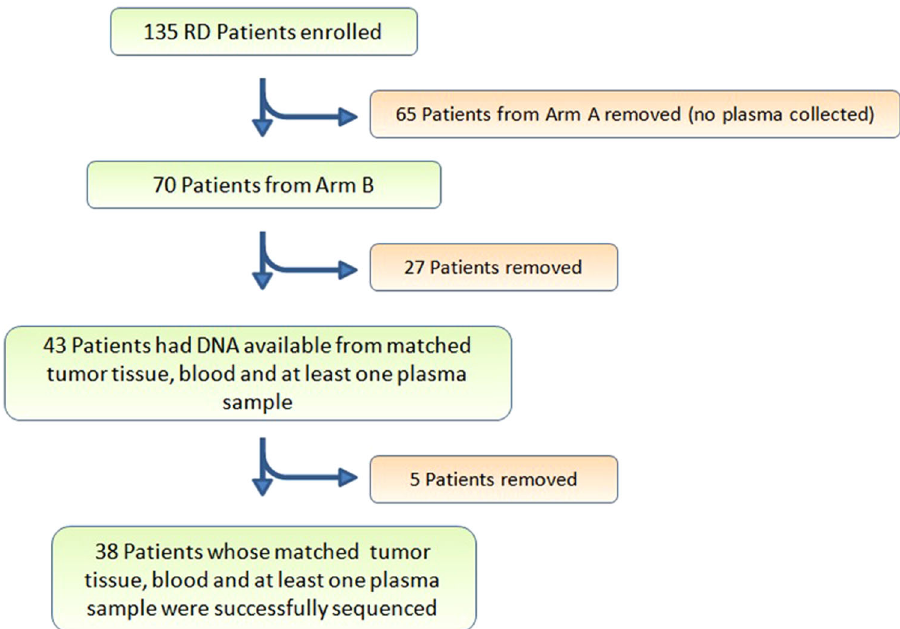
Fig. 2 CONSORT diagram. There were 135 patients enrolled in BRE09-146. In this study, we focused on 70 patients from Arm B. In Arm B, 27 patients did not have matched tumor tissue, whole blood, and at least one plasma collection and were excluded from this study leaving an N = 43. A further fi ve patients were removed due to the inability to successfully create a plasma DNA library. In total, 38 patients reached the criteria for